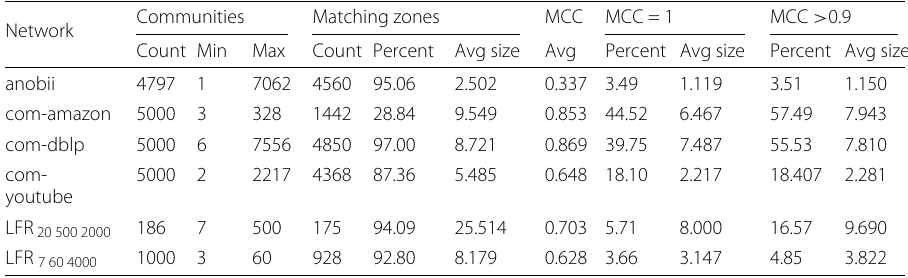
Table 17 Zones in networks with ground-truth communities Network